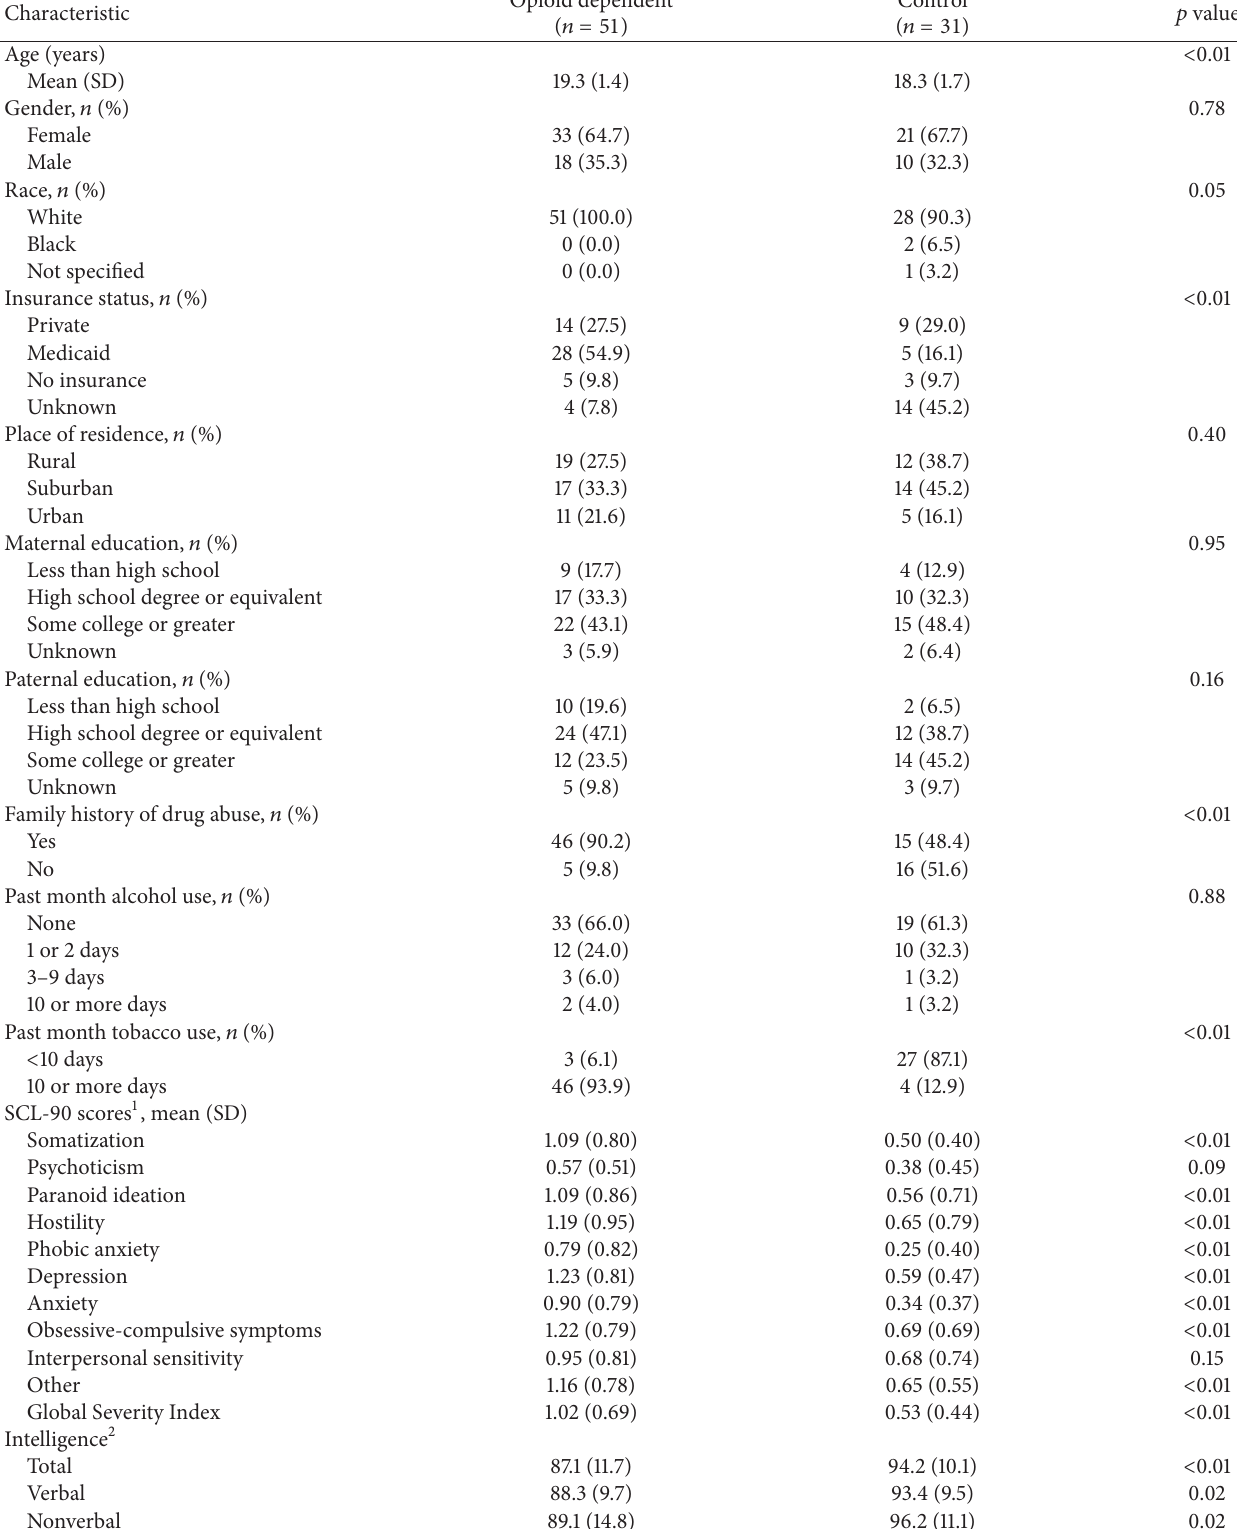
Table 1: Baseline subject characteristics by study group (opioid dependent versus